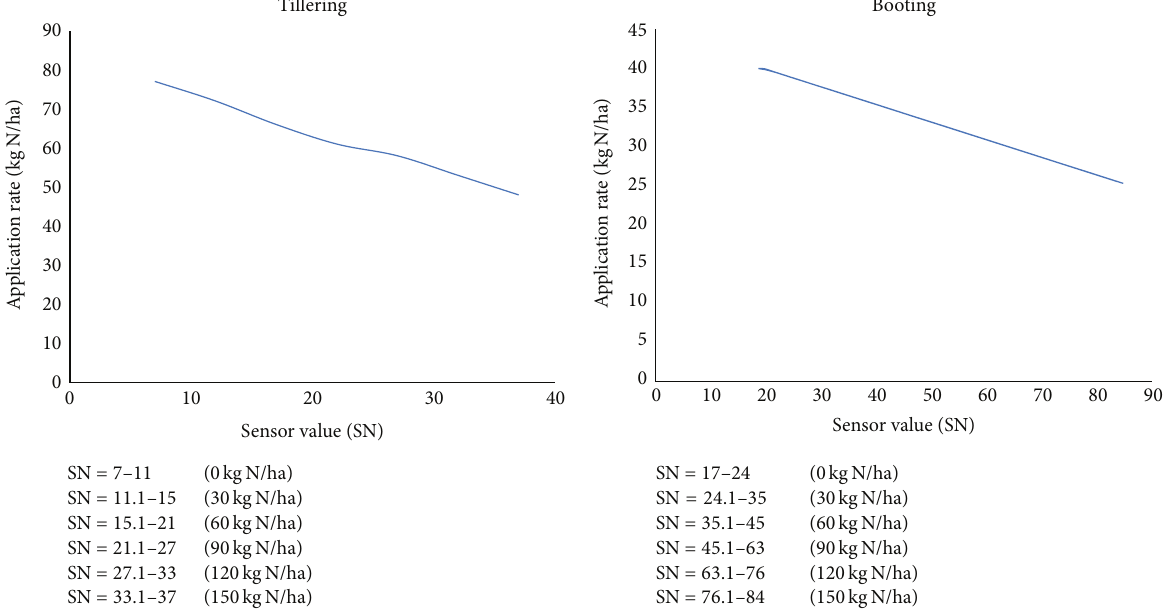
Figure 18: N-application (N app ) rate on the basis of N-sensor values (SN) during tillering and booting stages of wheat